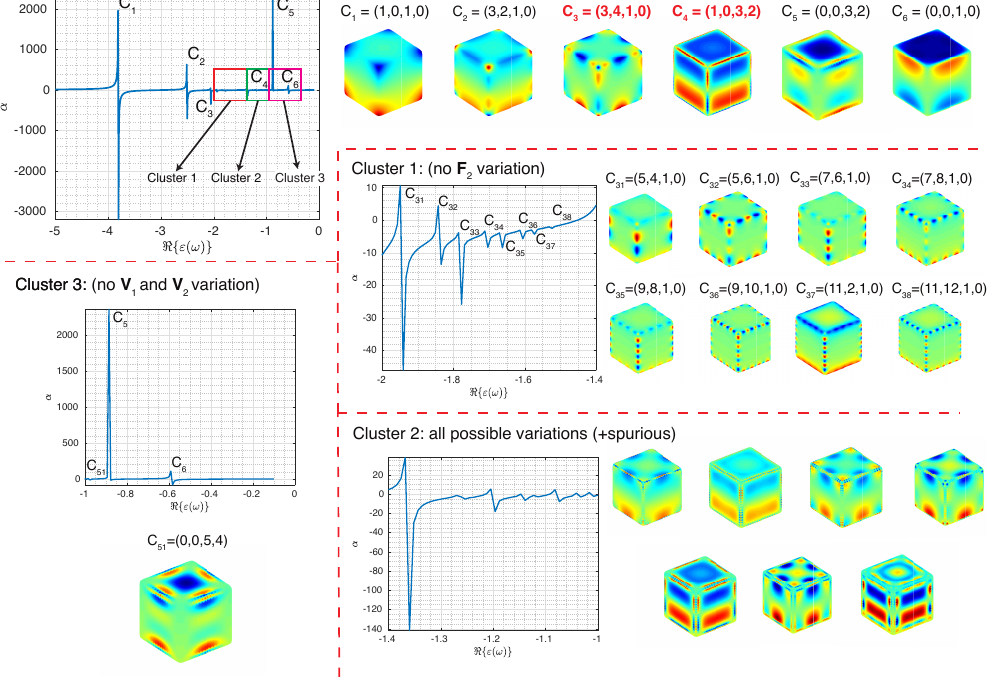
Figure 5. The six main resonances and the three particular clusters for the case of a smooth cube with p = 15 and a regular mesh. A total of 22 resonances and their surface potential distribution is presented. Above each resonance the categorization number is given, described in Figure 4. Please note that all resonances in clusters are more sensitive to modeling mesh density, than the main six resonances C 1 – C 6